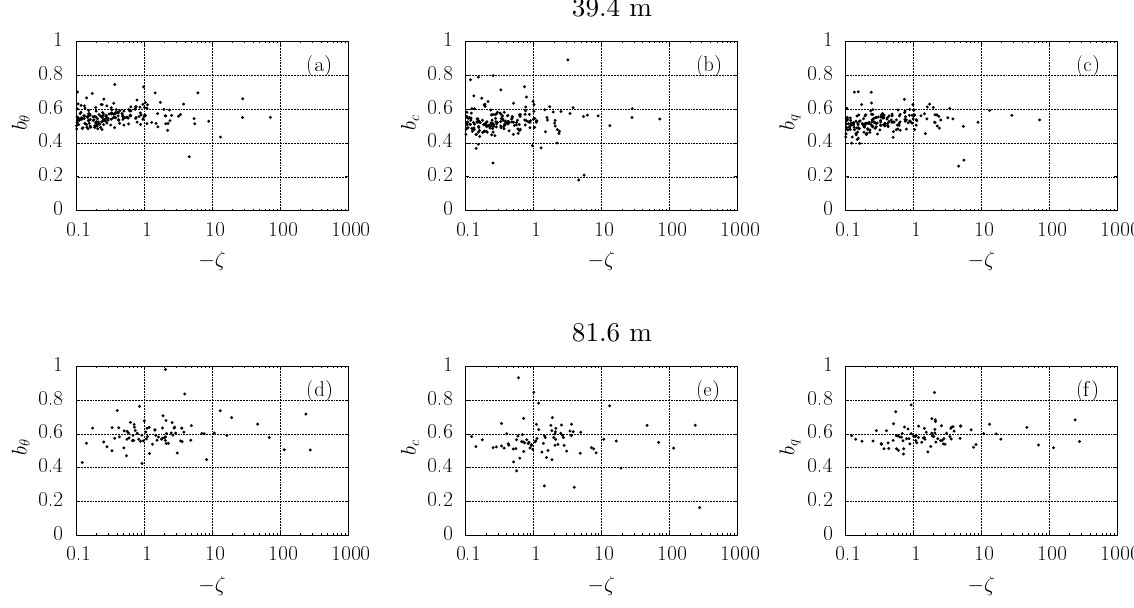
Figure 12. Relaxation coefficient variation with solar angle – 20 ◦ < | Z |≤ 60 ◦ . Panels (a, d) are temperature, (b, e) are CO 2 , and (c, f) are water vapor. Some data points were off the scale. Table 3. Statistics from REA at 39.4 and 81.6m, where b θ , b c , and b q are the relaxation coefficients for temperature, CO 2 , and water vapor,